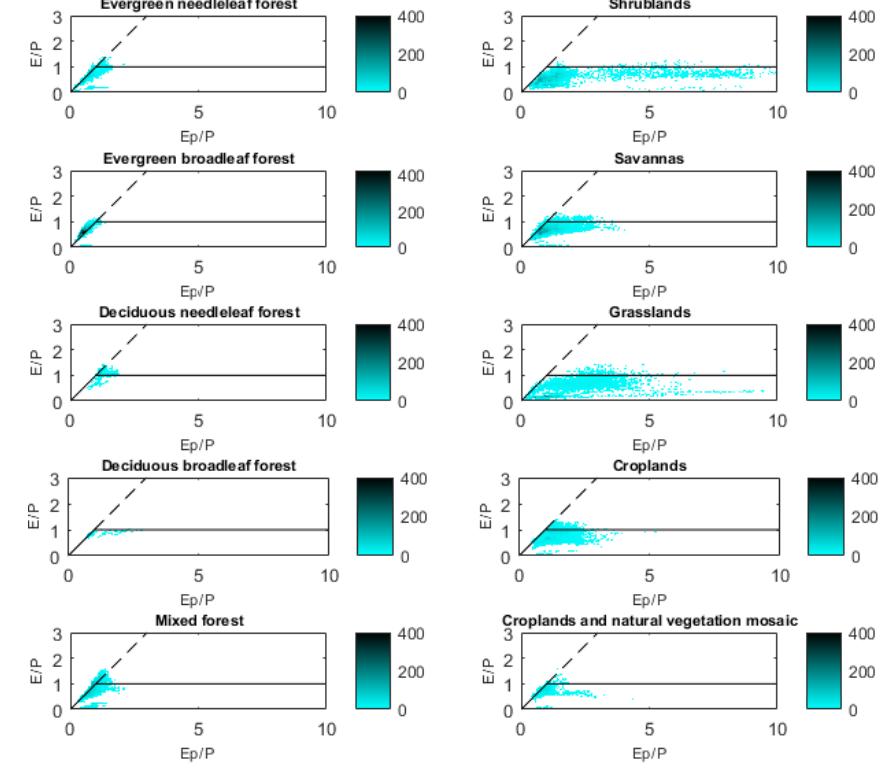
E p versus for each land cover. P P